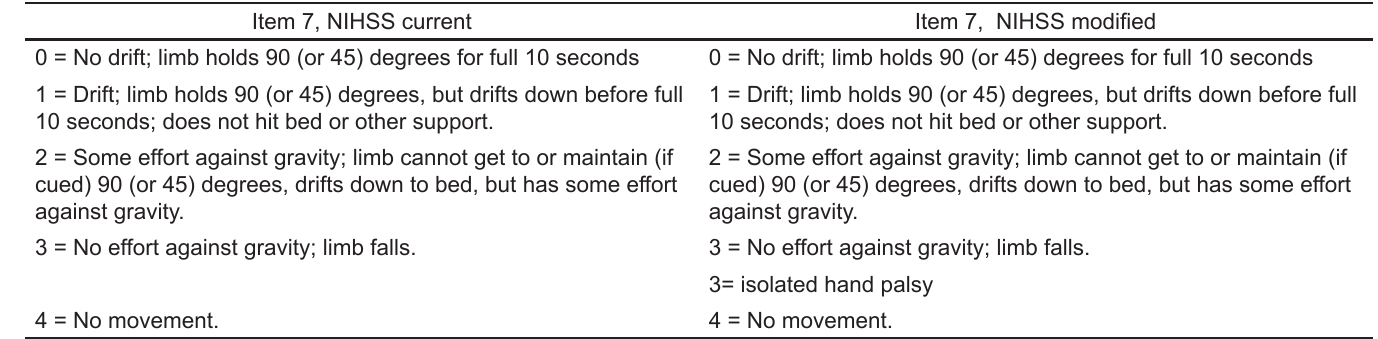
Table. National Institute of Health Stroke Scale (NIHSS) item 7 (current) and suggested modification to item